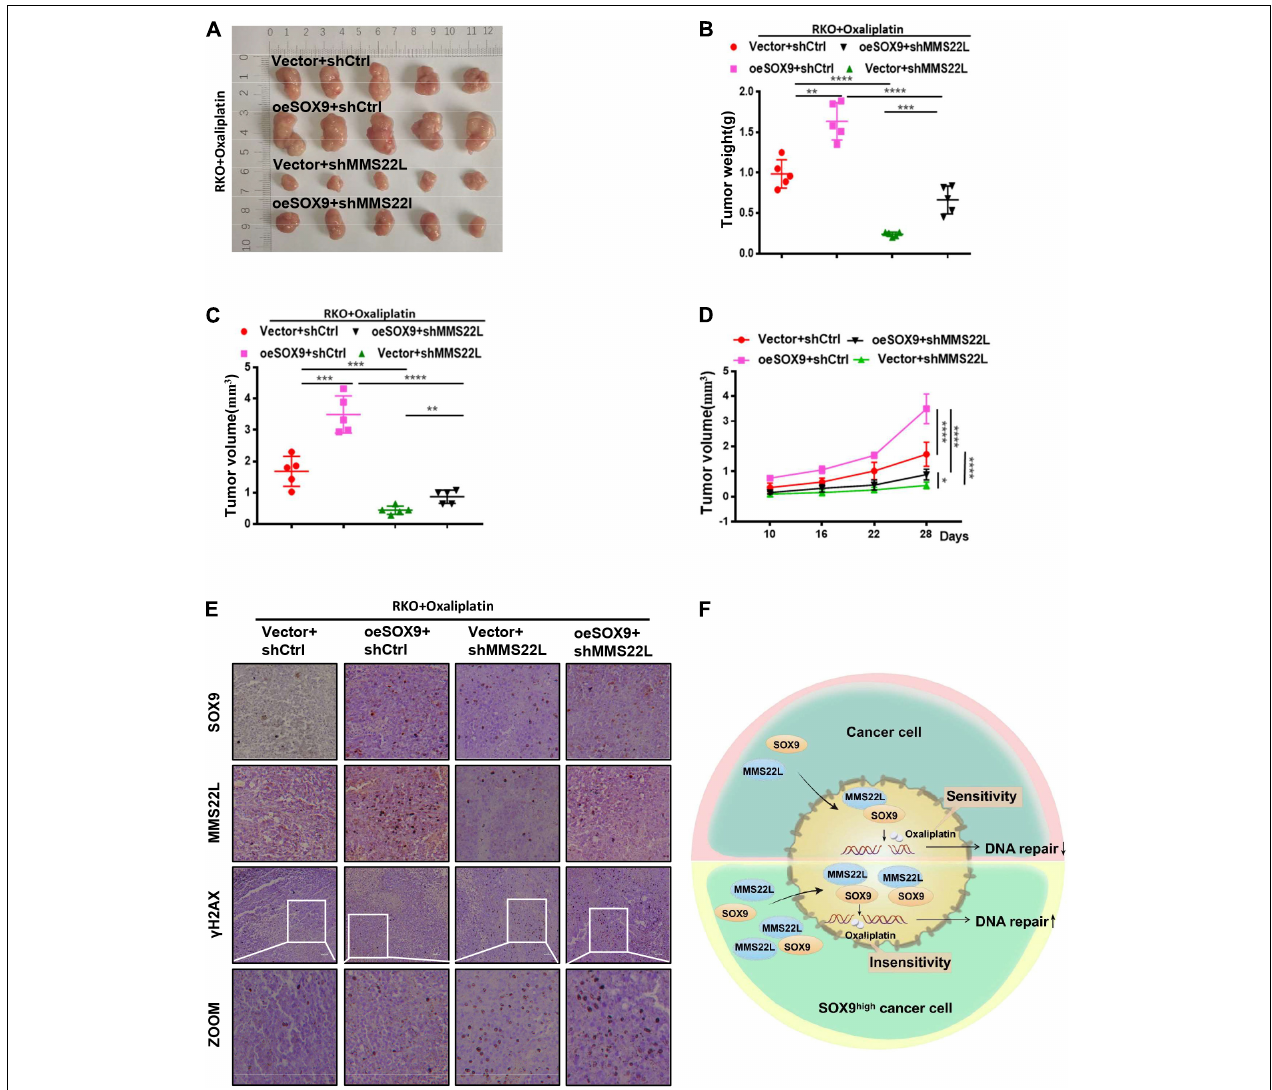
FIGURE 5 | Loss of MMS22L enhances chemosensitivity in SOX9-overexpressing CRC cells in vivo . (A–D) Antitumor outcomes of RKO xenografts in male nude mice treated with oxaliplatin, including photographs of the tumors (A) , average tumor weights (B) , and tumor volumes (C) , at the end of the experimental period, along with the time-dependent variation curves of tumor volume (D) . (E) IHC staining images showing the expression of SOX9, MMS22L, and γ H2AX in xenografts formed from Vector+shCtrl, oeSOX9+shCtrl, Vector+shMMS22L, and oeSOX9+shMMS22L cells. Scale bar = 50 µ m. (F) Schematic diagram of the regulatory mechanism by which SOX9-mediated expression and nuclear translocation of MMS22L promotes DNA damage repair in CRC cells. ** p < 0.01; *** p < 0.001; and **** p <